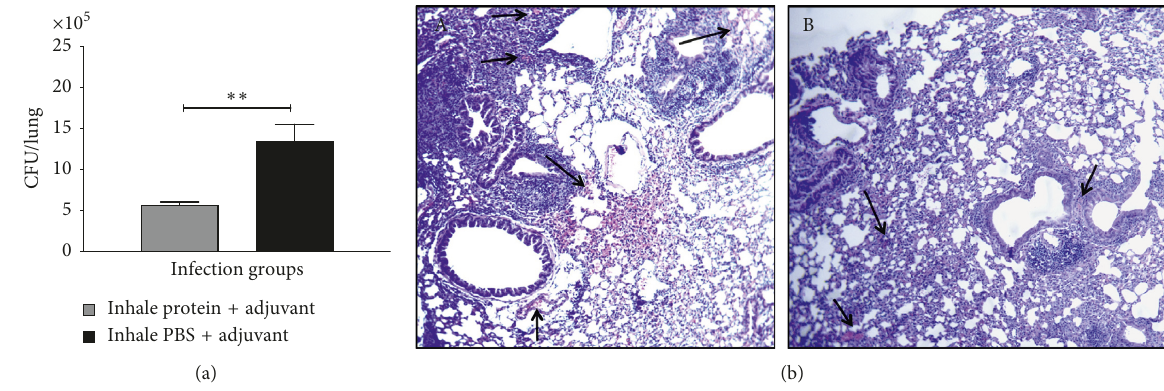
Figure 5: The number of viable bacteria in the lungs of the BCG challenged mice. (a) The colony forming units of M. bovis BCG were determined in the lungs of control nonimmunized (PBS inhalation) and the recombinant protein mix immunized mice ( n were challenged with M. bovis BCG as described in Section 2. Mice were sacrificed two weeks after the bacterial inoculation to identify the viable BCG. Results are expressed as CFUs for the individual mice, and the mean values for each group are provided.